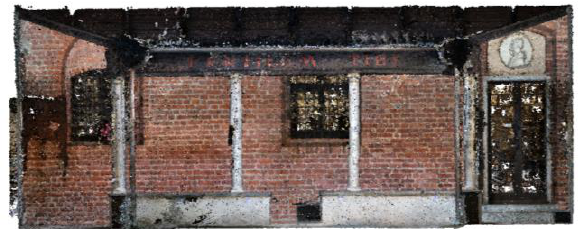
Figure 6. Pointcloud of the western wall of the cloister Due to various inaccuracies that could not be avoided, it was necessary to integrate the mesh obtained with photogrammetry with various parts modelled as NURBS on Rhinoceros software, using the mesh from photogrammetry as a basis for modelling (in order to guarantee an accurate reconstruction) (Fig. 7).